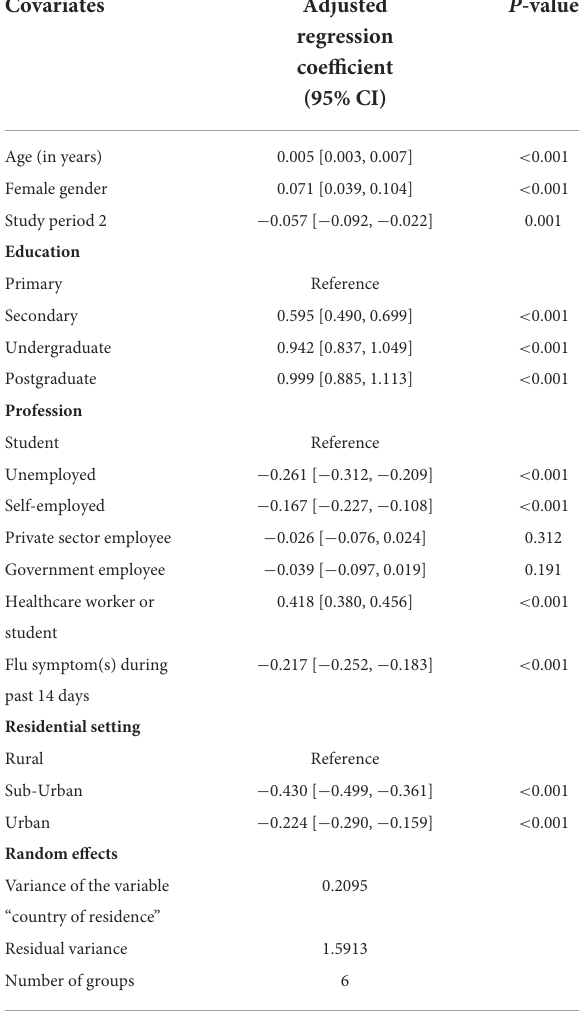
TABLE 3 Multivariable model investigating determinants of adherence score ( N = 26,575). Covariates Adjusted